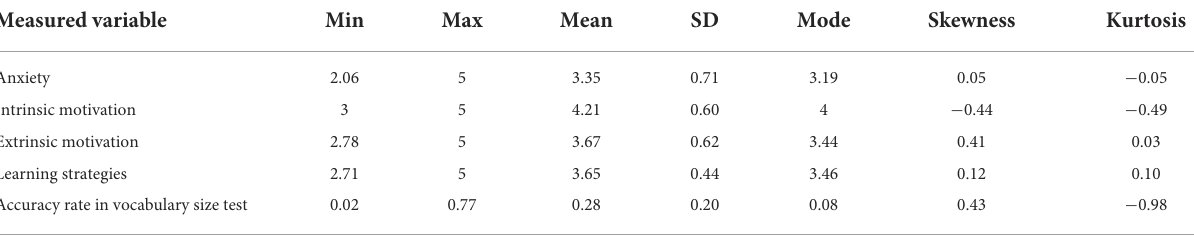
TABLE 3 Scores in motivation, anxiety, learning strategies and vocabulary size test.